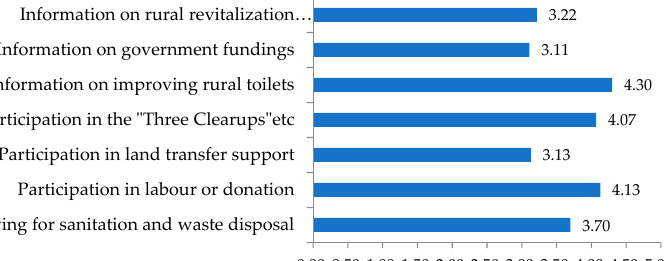
Figure 3. Farmers’ participation in SDR practices.